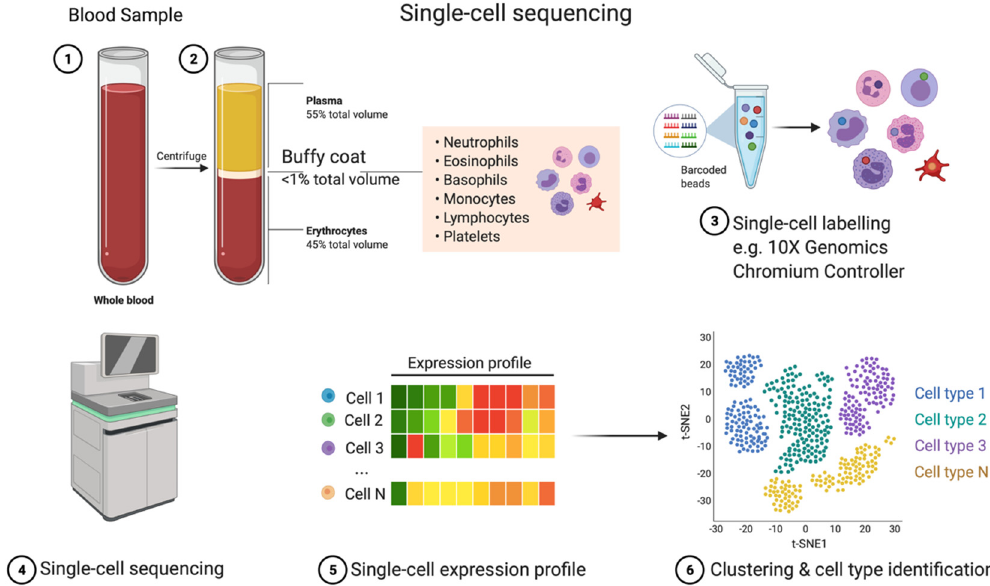
Figure 1. Single cell transcriptomics is a technology used to resolve RNA-seq data at a single cell level, and thereby all mRNAs (and miRNA and lncRNA where the technology permits). Cells may be derived from homogenized tissues, but also from the immune cell component (Buffy coat) from whole blood samples. This technique allows for gene activity measurements from all cells present in a sample, assuming highly efficient cell labeling. Cell samples are isolated, and each cell is individually labeled using sequencing bar code technologies, e.g., microfluidics. Labeled cells can then be re-pooled and sequenced. Finally, data are analyzed, and gene clusters are associated into cell types or tissue domains. Adapted from Single Cell Sequencing, by BioRender.com (2021). Retrieved from https://app.biorender.com/biorender-templates.